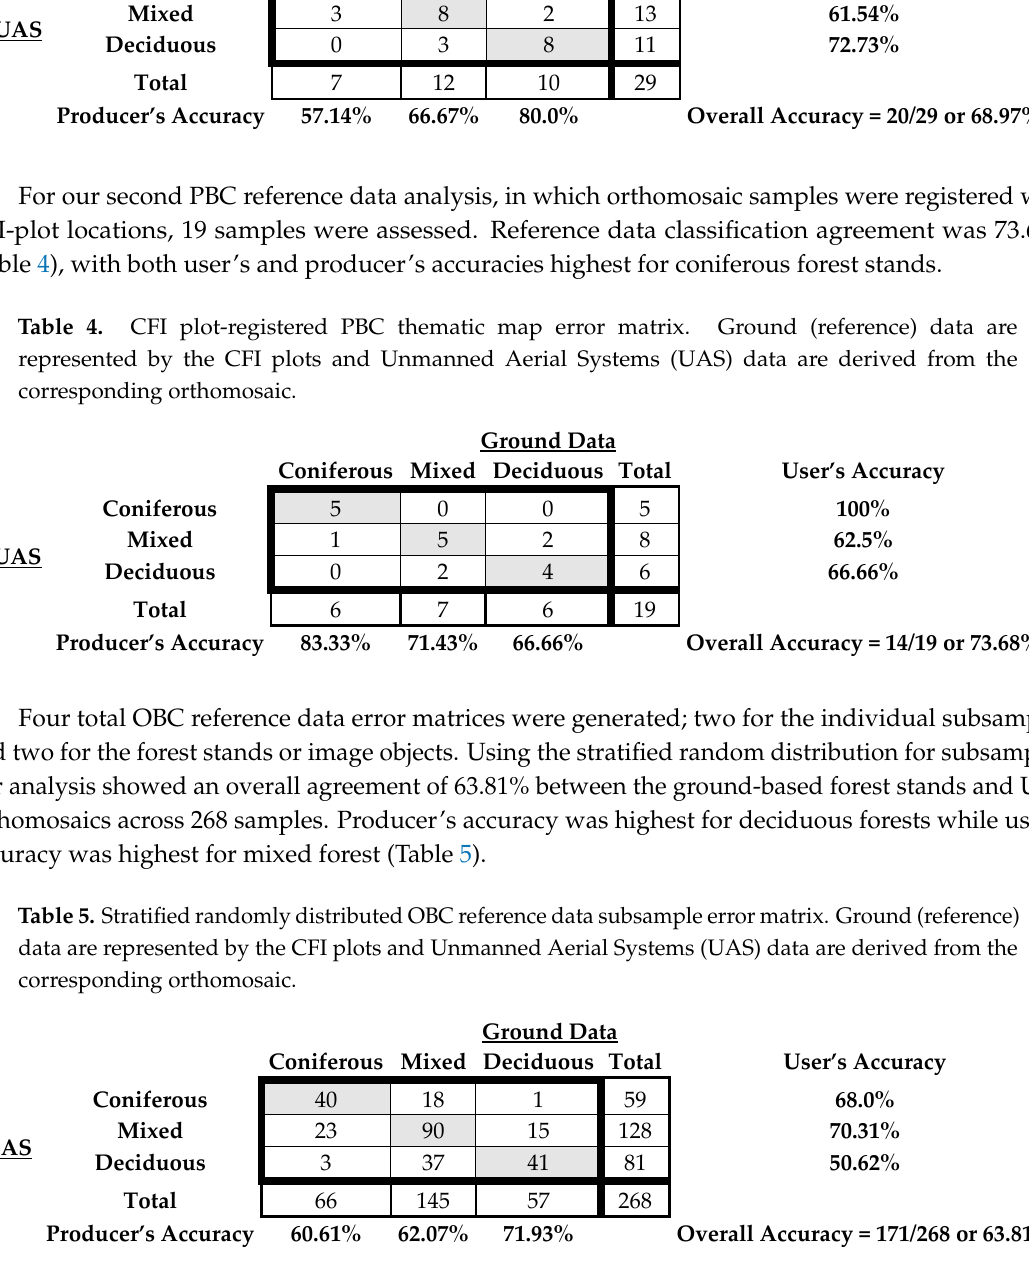
Table 3. Stratified random sampling PBC thematic map error matrix. Ground (reference) data are represented by the CFI plots and Unmanned Aerial Systems (UAS) data are derived from the corresponding orthomosaic.